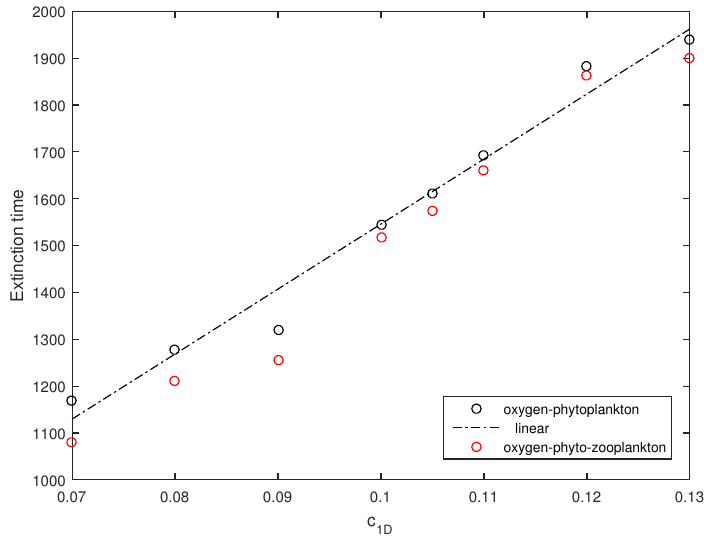
Figure 13. Average extinction time calculated for different values of c 1 D for the oxygen-phytoplankton model ( v 0 = 0, black circles) and the full oxygen-phyto-zooplankton model ( v 0 = 0.01, red circles). Other parameters are the same as in Figure 12. The black dashed-and-dotted straight line shows the best-fit of the data by a linear